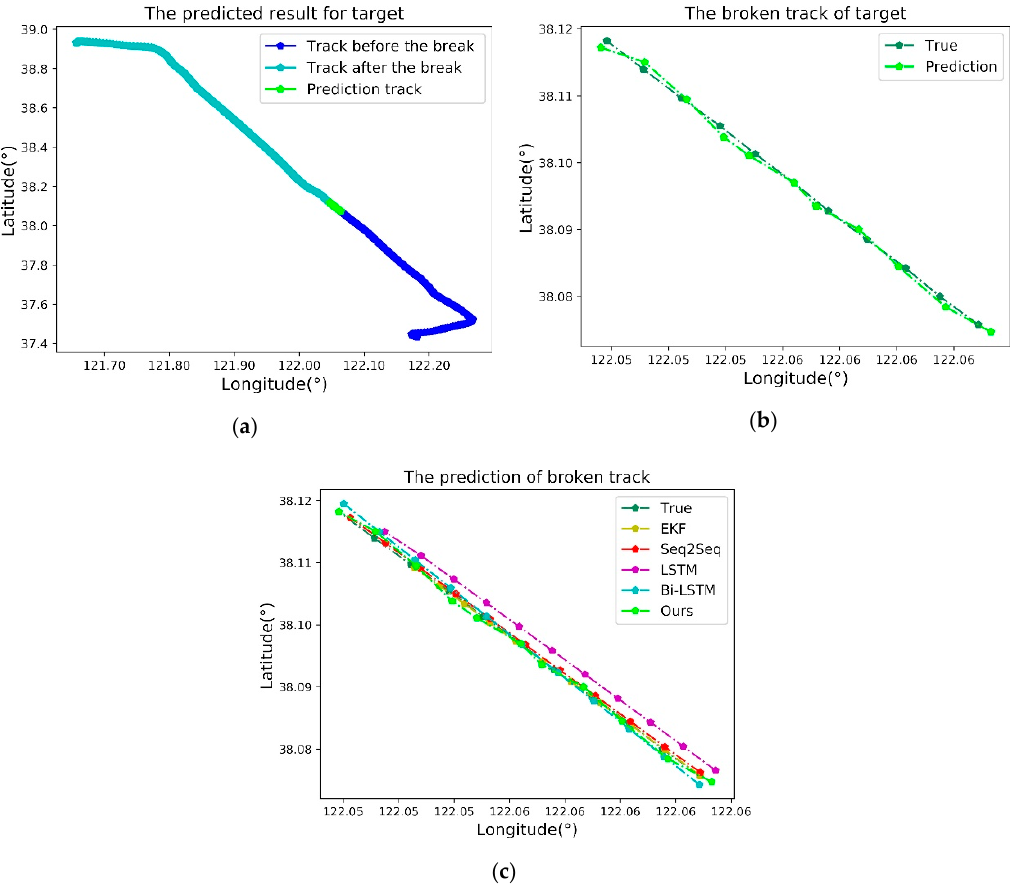
Figure 16. ( a ) The real target trajectory verification. The blue, cyan, and green lines represent, respectively, the track before the break, the track after the break, and the predicted track at the break. ( b ) Comparison of the forecast and the real AIS data. ( c ) Comparison of the broken track prediction with the other mainstream algorithms including EKF, Seq2Seq, LSTM and Bi-LSTM.